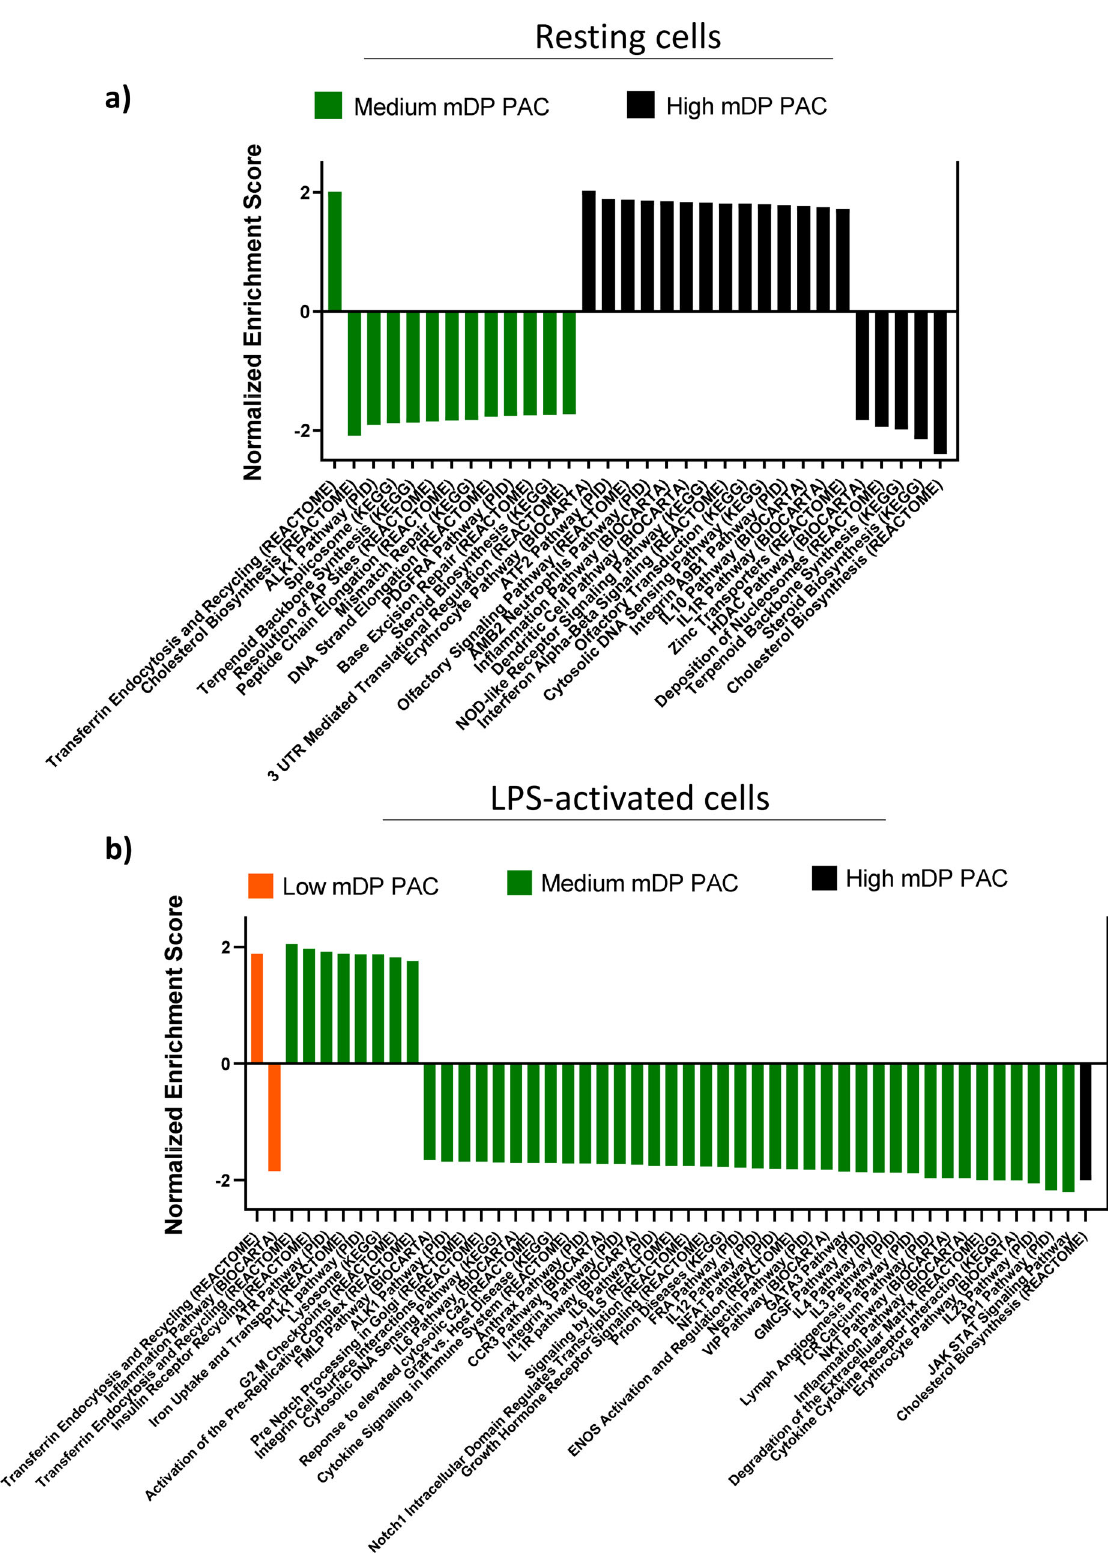
Fig. 4 Regulation of gene pathways in RAW 264.7 macrophages stimulated with proanthocyanidins with differing degrees of polymerization. a Gene pathways regulated by medium mDP (9.1) and high mDP (12.3) grape pomace proanthocyanidins (PAC) in resting RAW 264.7 macrophages. b Gene pathways regulated by low mDP (2.6), medium mDP (9.1), and high mDP (12.3) grape pomace PAC in lipopolysaccharide-activated RAW 264.7 macrophages. Experiments were conducted with triplicate samples. Shown are signi fi cantly regulated pathways ( p value <0.001; q value <0.15) identi fi ed by gene-set enrichment